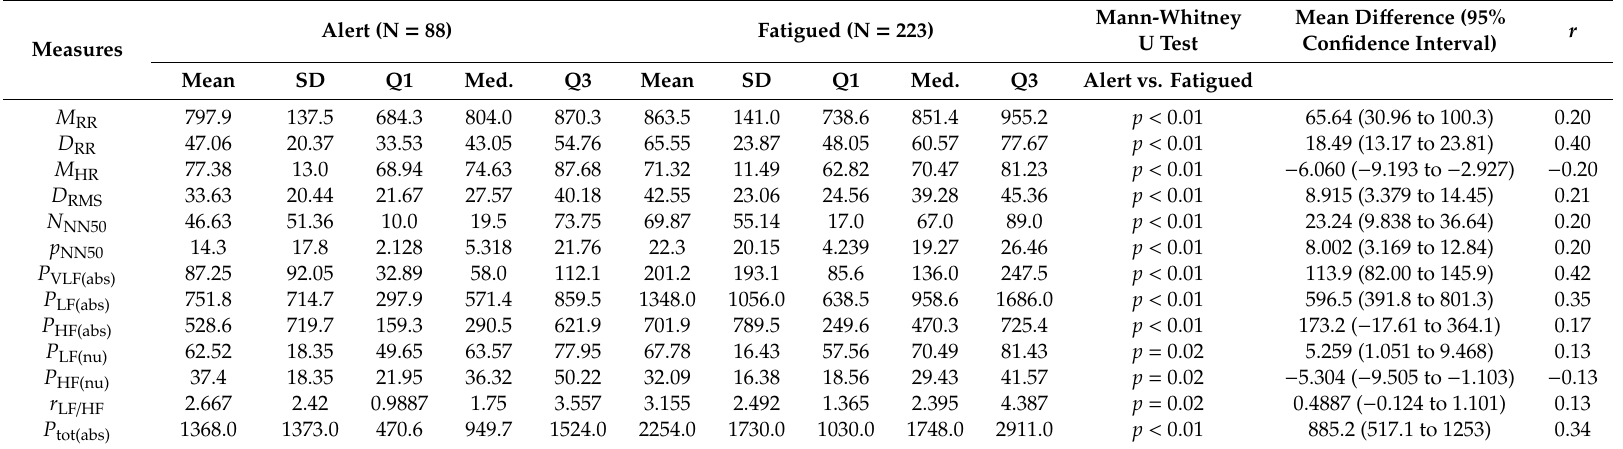
Table 4. Descriptive statistics and results of Mann-Whitney U tests of HRV time domain and frequency domain measures of drivers with di ff erent mental states.